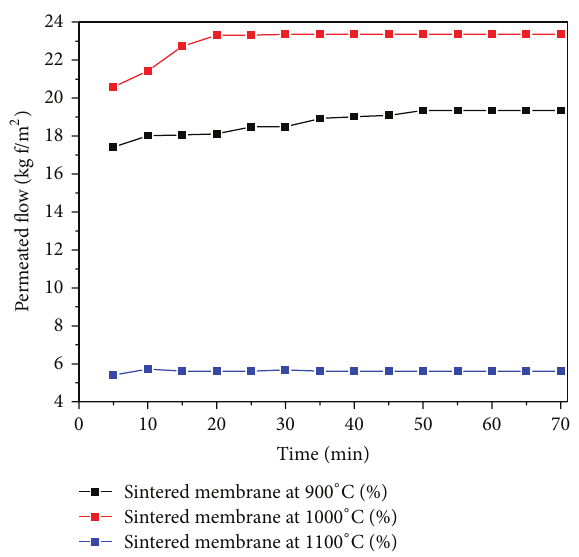
Figure 8: Turbidity of textile effluent before and after permeation through the sintered ceramic membranes at 900, 1000, and 1100 ∘